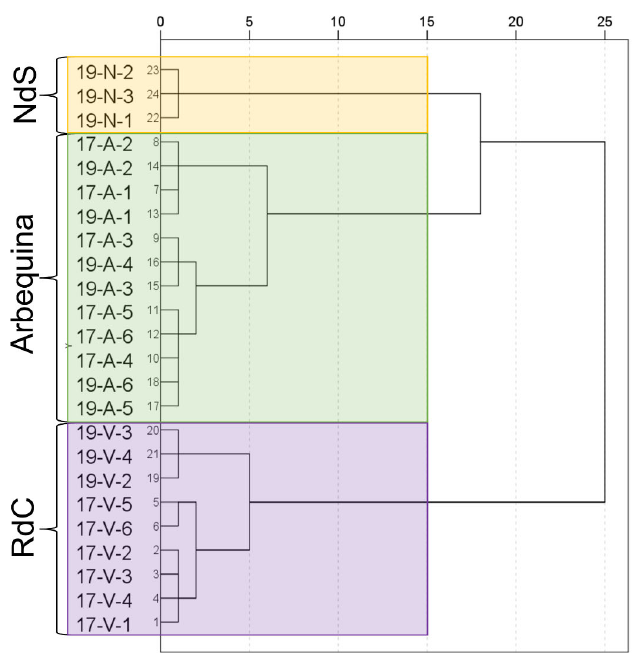
Figure 7. Dendrogram for the dataset. Cultivar: “Negral de Sabiñán” (N), “Royal de Calatayud” (V), and “Arbequina” (A). Sample coding: YY ‐ C ‐ X (YY: crop year; C: cultivar; X: harvest date). Crop